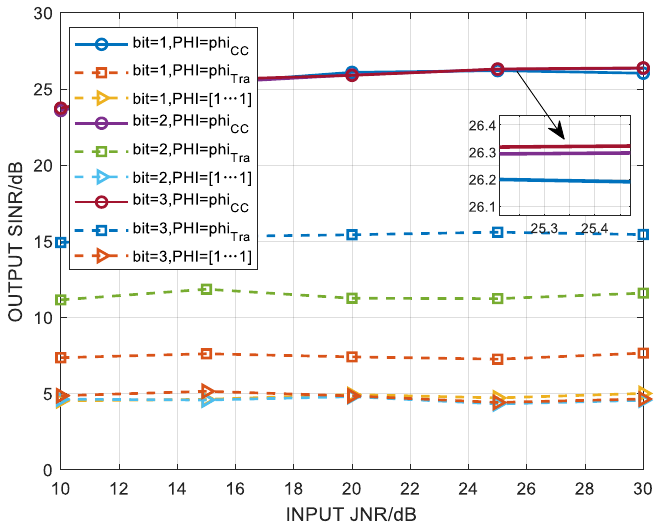
Figure 6. Comparison of the anti-jamming performance of different algorithms based on the number of bits in a single metamaterial element.